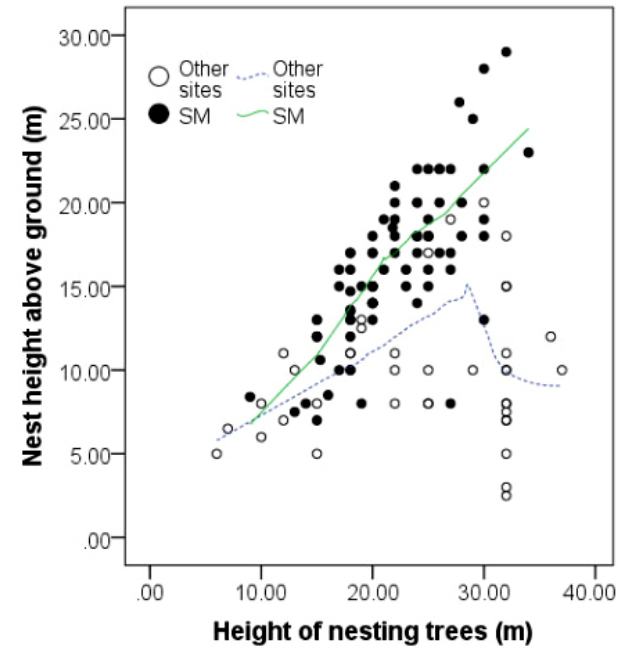
Fig. 5 . Relationship of nest height above ground (NAGH) and tree height (TH) in Shimen (SM) and other sites. Note: the solid point indicates data in SM, and the hollow point indicates data in the other sites; the solid curve indicates trend of NAGH change with the TH in SM, and the dotted one indicates the same in the other